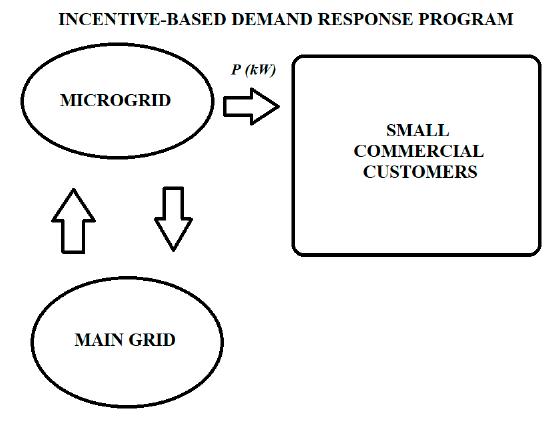
Figure 6. Simplified Power System.